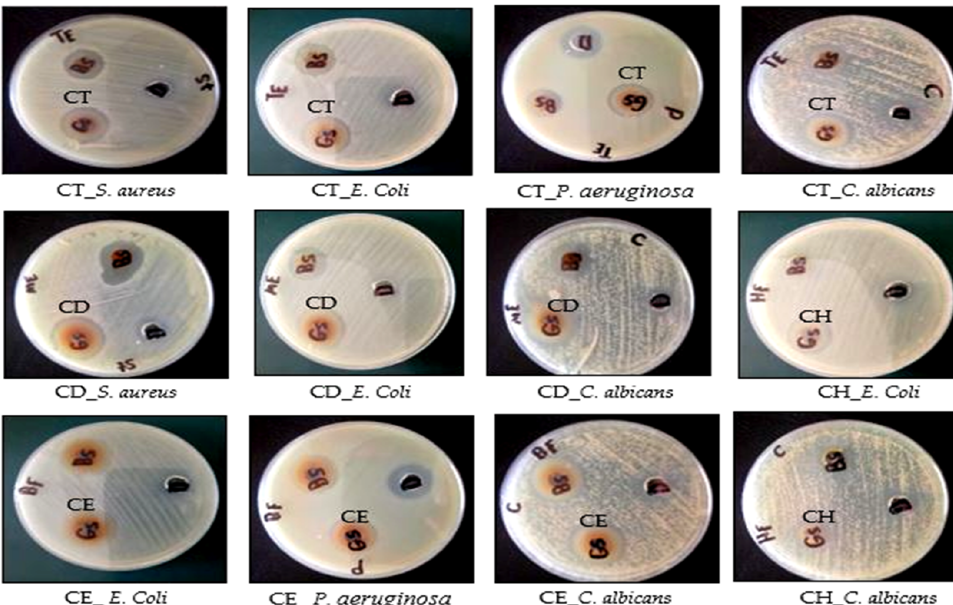
Figure 9. Antimicrobial activity of Cliona sp. Total extract (CT), n -Hexane (CH), Dichloromethane (CD), and Ethyl acetate (CE) fractions by agar dilution method with S. aureus , E. coli , P. aeruginosa , and C. albicans . Ciprofloxacin (antibacterial) and Fluconazole (antifungal) were used as positive controls while DMSO was the negative control.